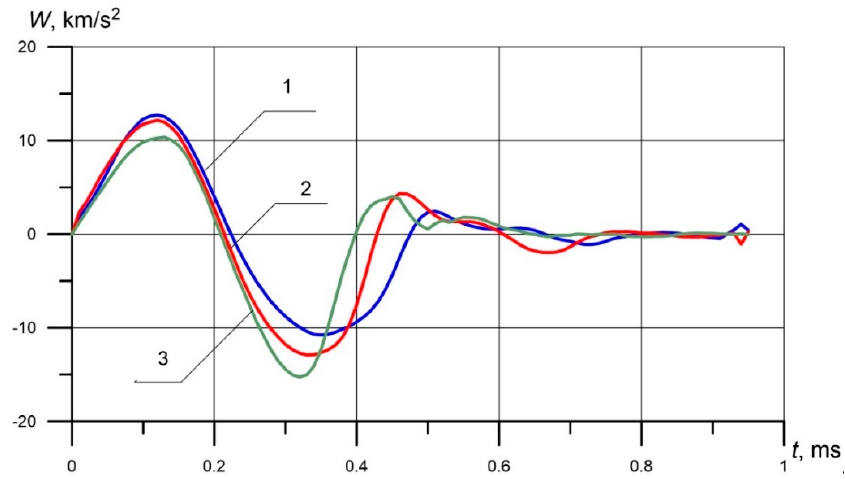
Figure 4. The relationship of the acceleration of the conical indenter 90 on time during the impact: ( 1 ) 96 HB, ( 2 ) 182 HB, ( 3 ) 450 HB.